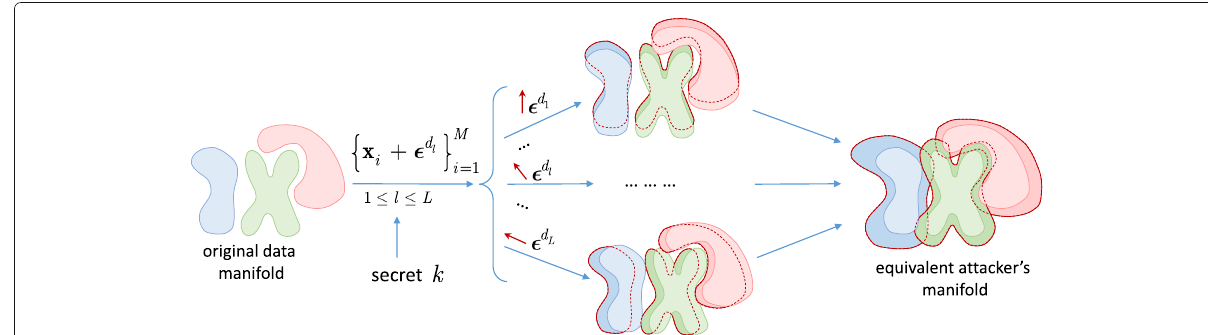
Fig. 5 Explanation of multi-channel randomization: given a training data set, the defender introduces a random perturbation (cid:3) d l , 1 ≤ l ≤ L , to each sample { x i } M i = 1 and trains L classifiers. Since the perturbation is known at training, i.e., all samples obtain the stationary “bias” by (cid:3) d l for the same classifier l , the randomization has a limited impact on the classifier performance. Since the attacker has no access to the defender’s perturbations and all of them are equilikely, an equivalent manifold for the attacker is expanded thus leading to higher entropy and thus increasing the learning